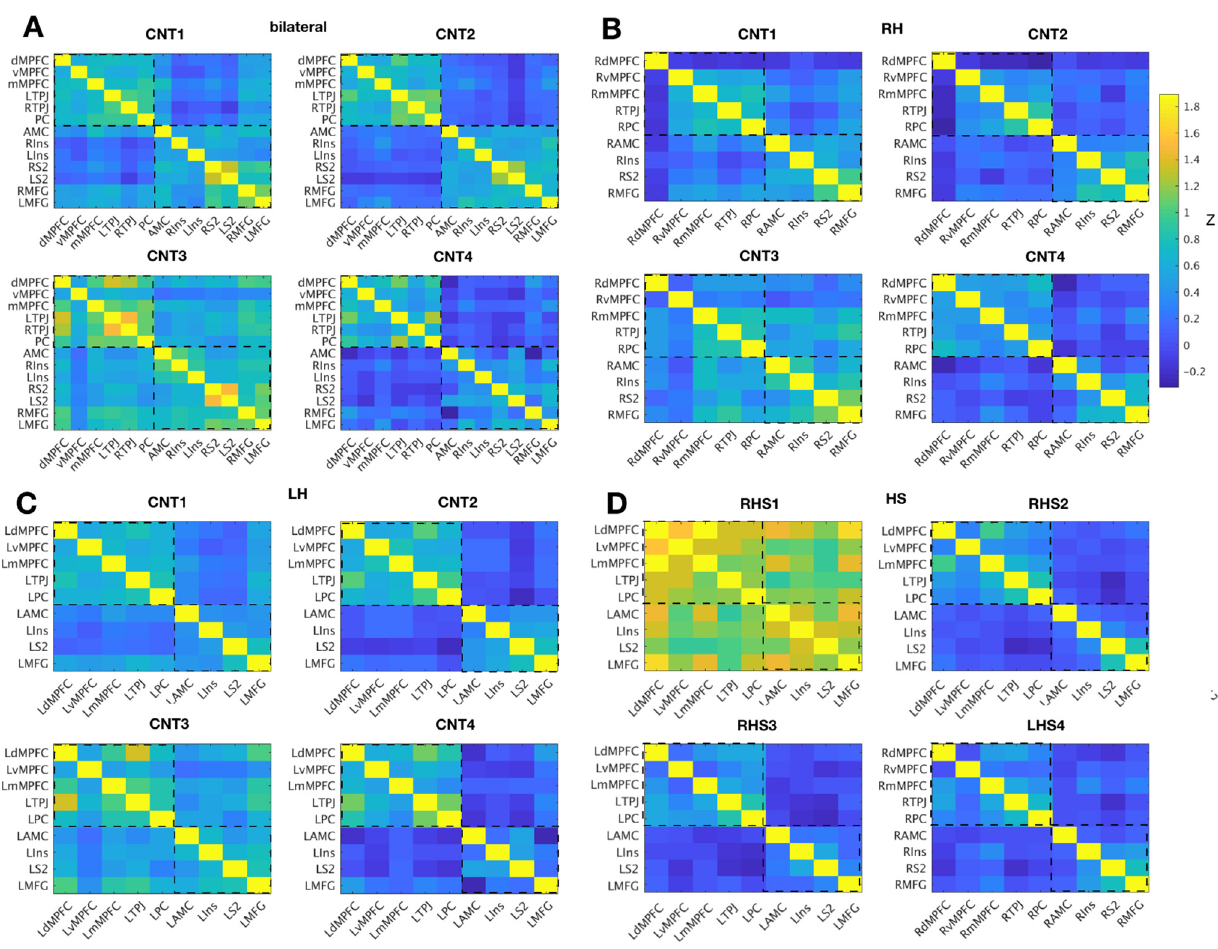
Figure 3. Correlation matrices indicating strength of correlations (Fisher’s z) per sample across regions of the ToM and PAIN network for the original ( A ), right lateralized ( B ) and left lateralized ( C ) sets of ROIs in the comparison participants (CNT), as well as HS participants ( D ). ToM network ROIs are listed at the top of the y axis and left on the x-axis: dMPFC = dorsal medial prefrontal cortex, vMPFC = ventral medial prefrontal cortex, mMPFC = middle medial prefrontal cortex, PC = precuneus PC, TPJ = bilateral temporal-parietal junction. PAIN network ROIs include: AMCC = anterior mid-cingulate cortex, ins = insula, MFG = middle frontal gyrus and S2 = secondary somatosensory cortex. Hemispheric lateralization of ROIs is indicated by R or L prior to the ROI abbreviation. Abbreviations: LH, left hemisphere; RH right hemisphere; CNT1-4, comparison individuals; RSH1-3 right hemispherectomy individuals; LHS4, left hemispherectomy